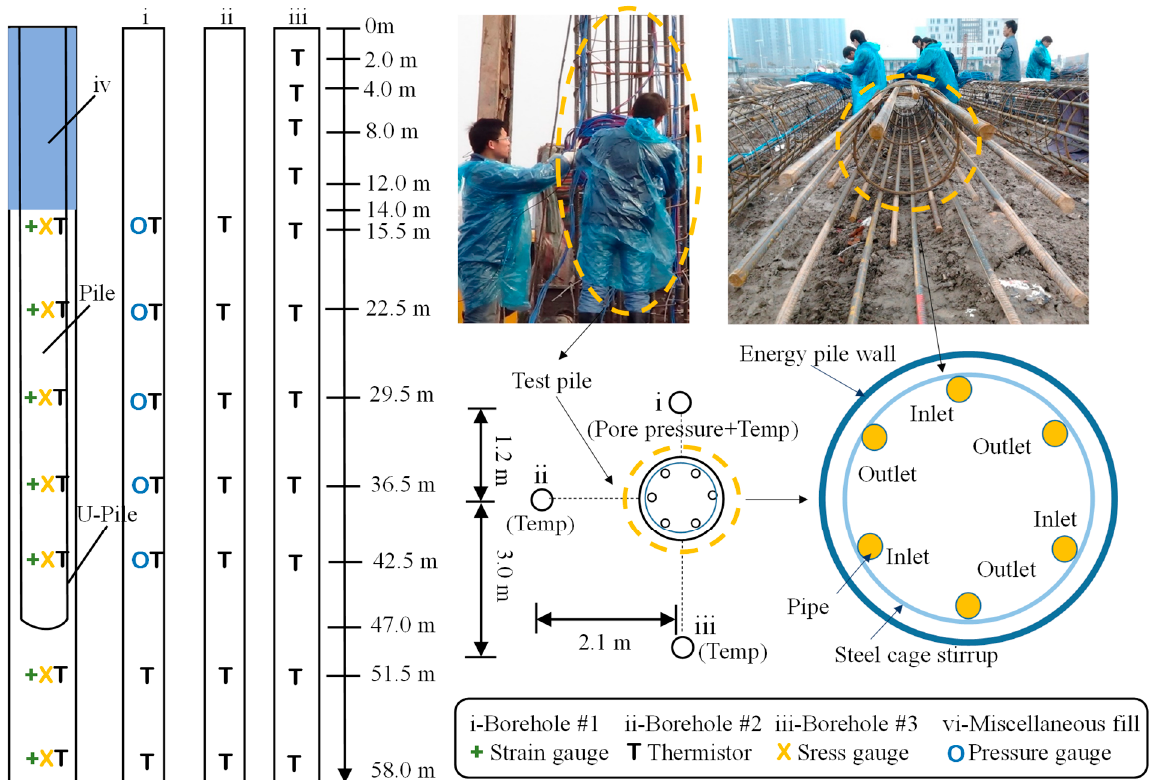
Figure 3. Test conditions and sensor layout.